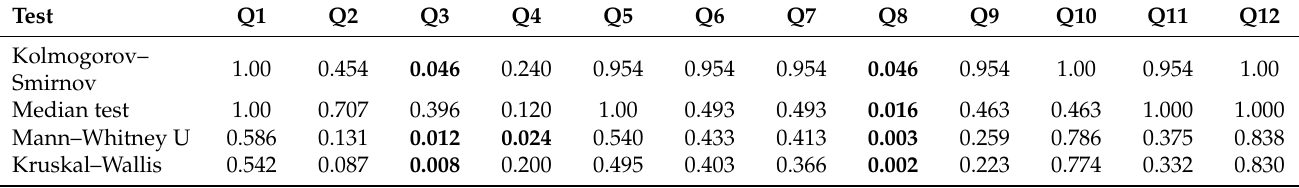
Table 4. The p -values of all questions included in the survey were rated using a Likert scale. Results in bold are those where the p -value was below the significance level